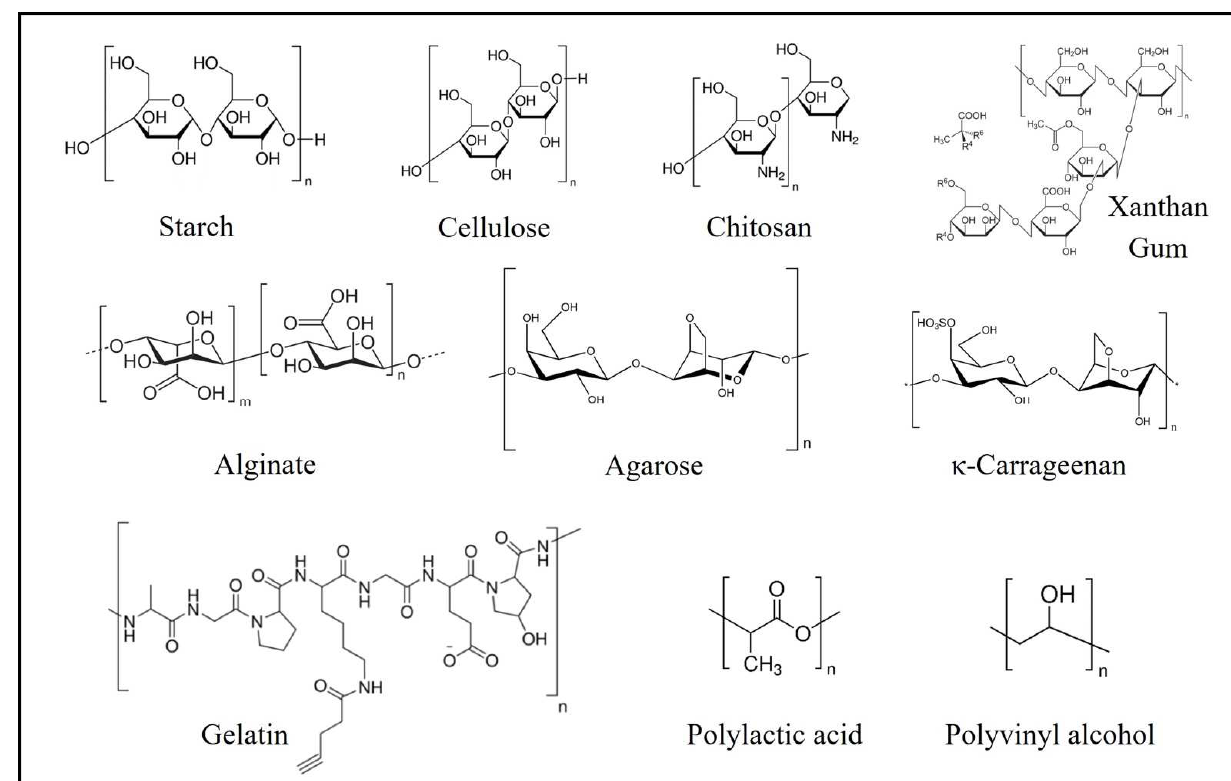
Figure 3. Molecular structure of various biopolymers used in food packaging.